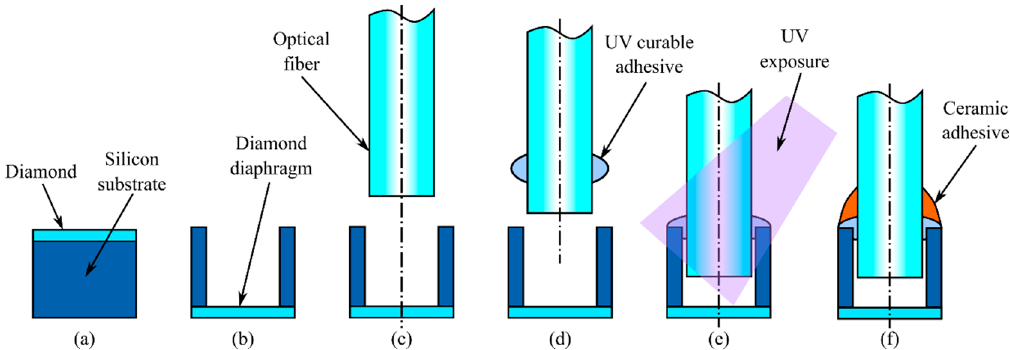
Figure 2. The fabrication process of the diamond-based pressure sensor ( a – f ).